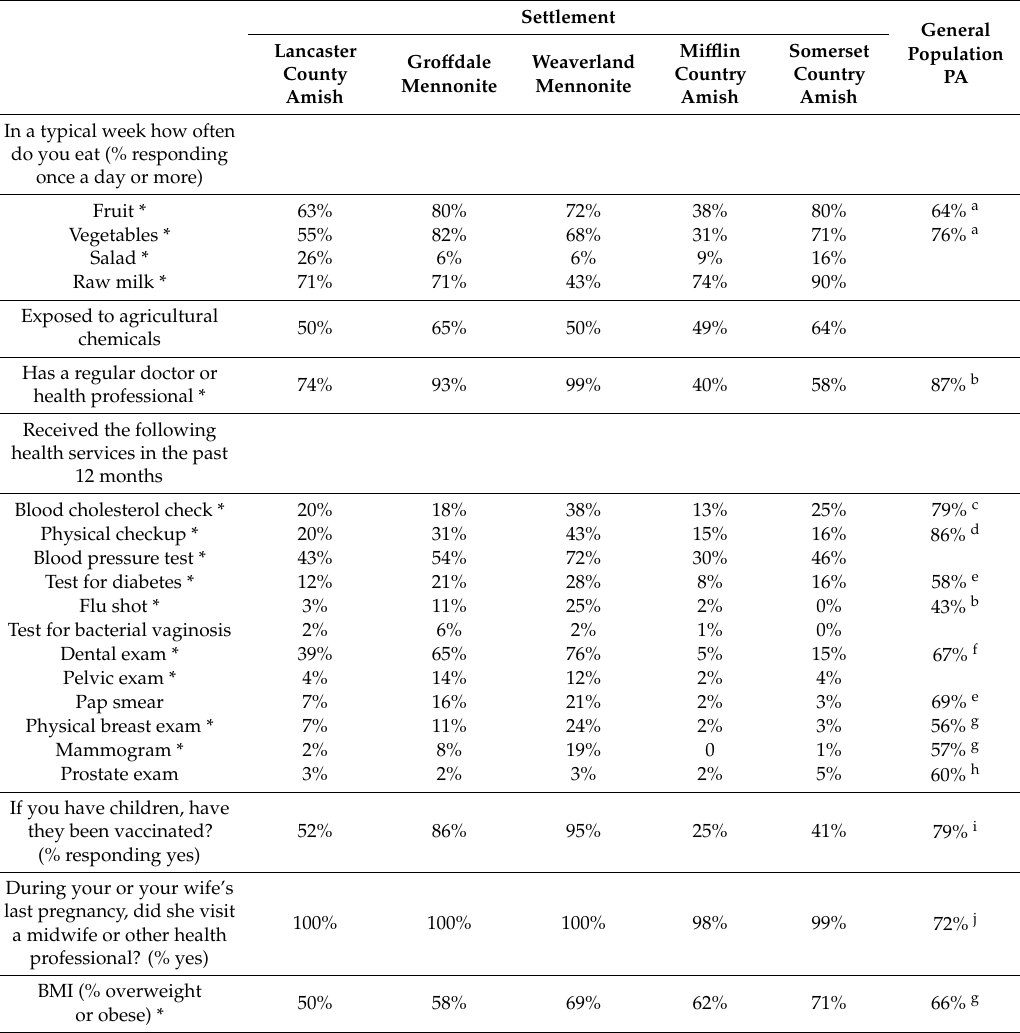
Table 3. Behaviors and exposures of 5 Pennsylvania Plain communities and the general Pennsylvania